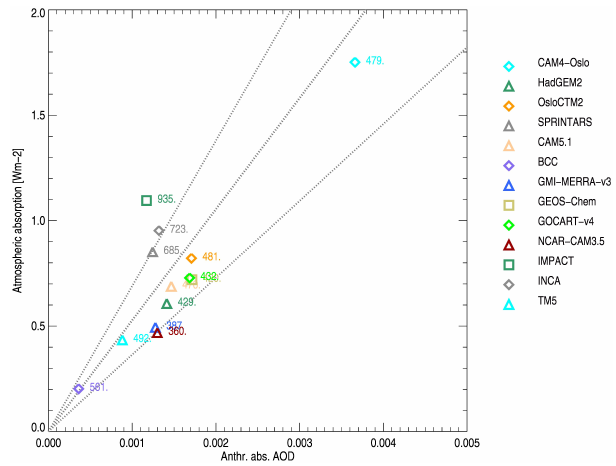
Fig. 6. Correlation between anthropogenic absorption AOD and atmospheric absorption. Numbers show ratio AtmAbs/AAOD, the lines indicate the mean and one standard deviation of this ratio. R 2 = 0 . 73